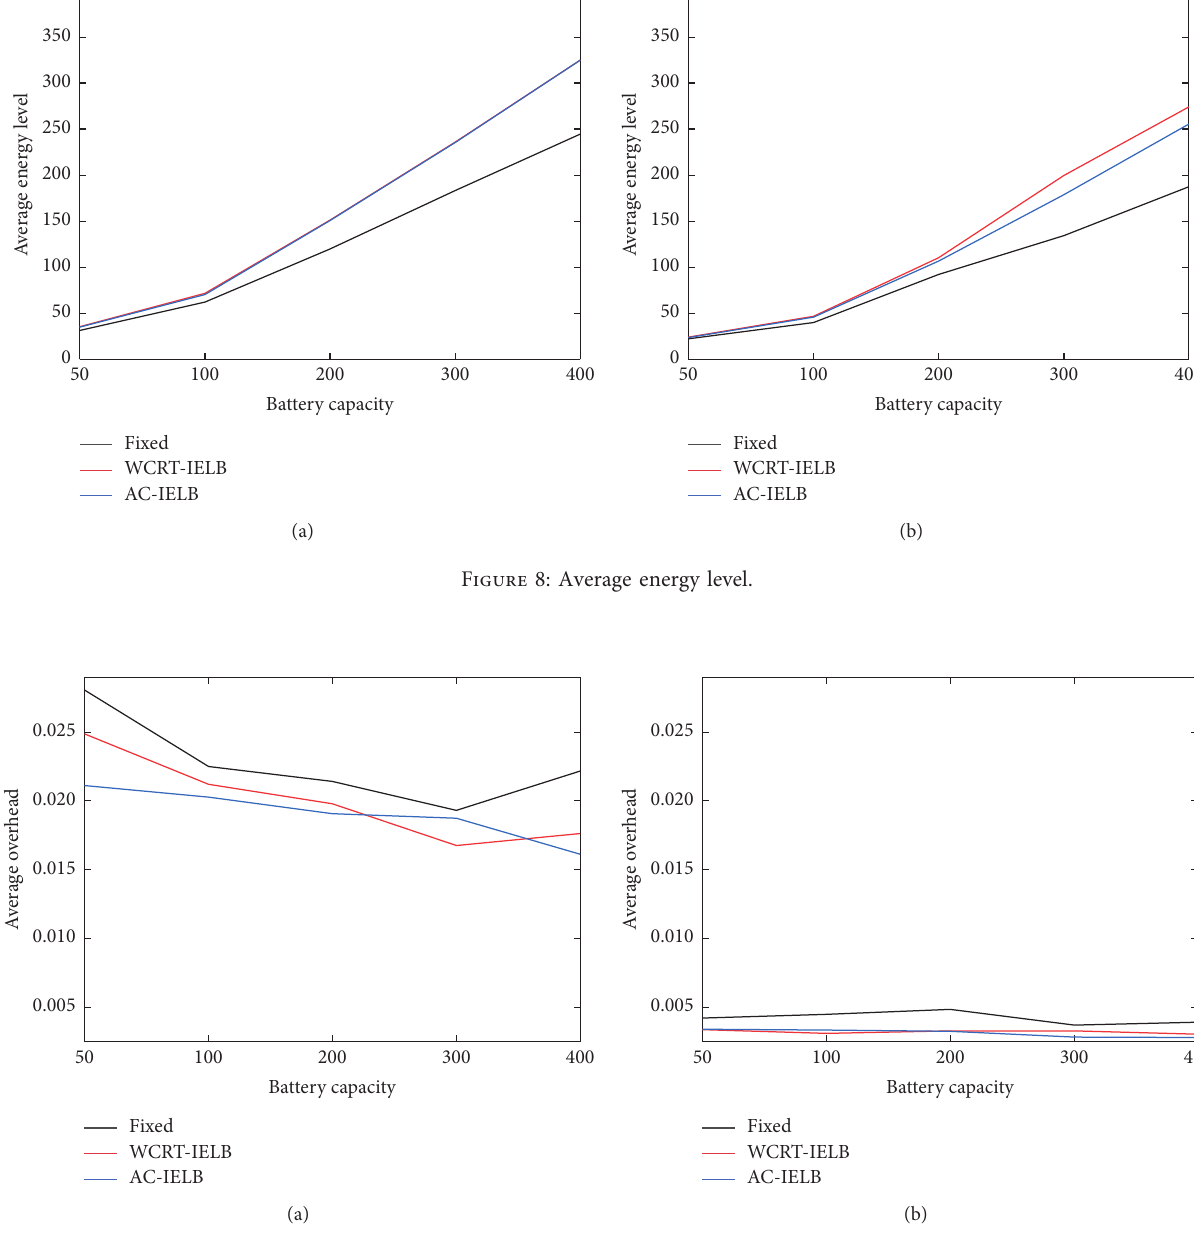
Figure 9: Average